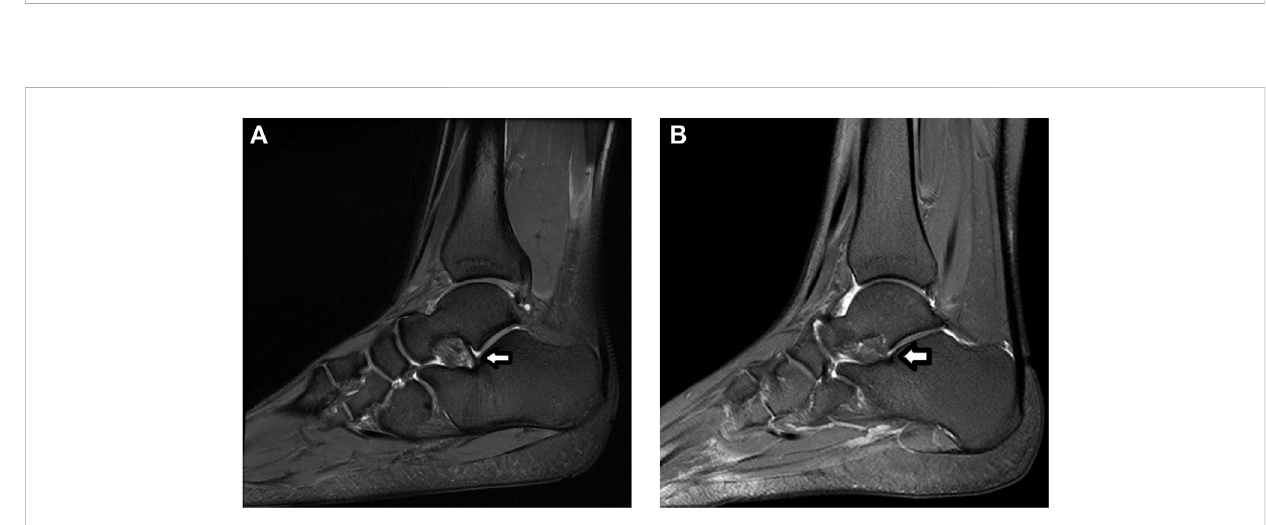
FIGURE 7 MRI assessment of the ACaL (white arrow) on sagittal image. Proton density image with fat suppression. (A) . Normal ACaL. (B) . Abnormal